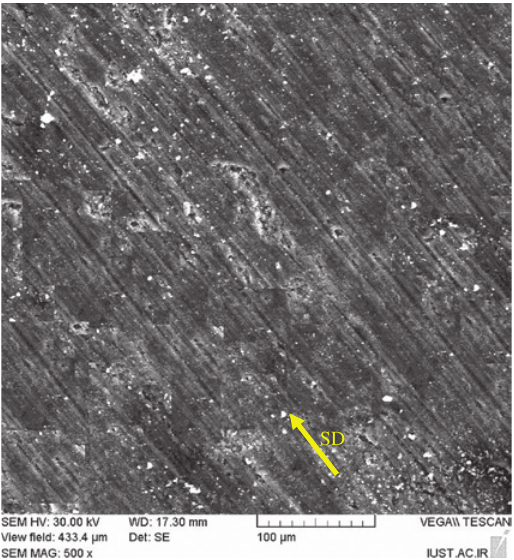
composite at peak p